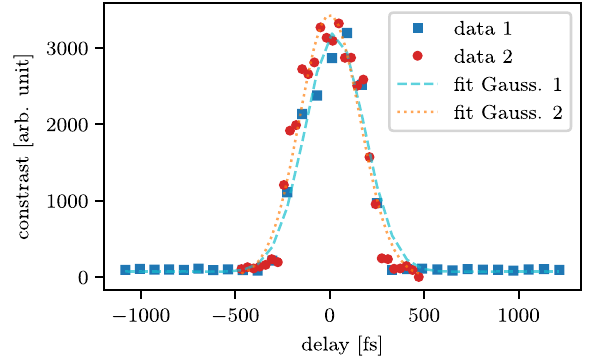
FIG. 34. Variation of the TDB and the temperature measured on the MPS bodies under